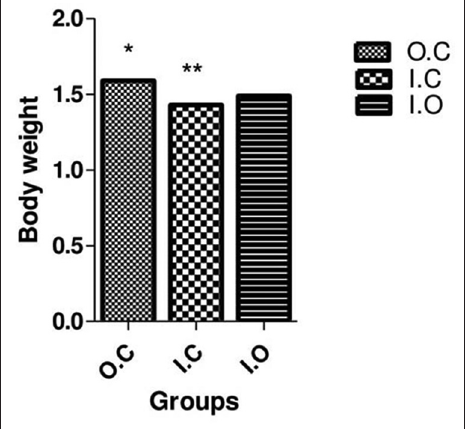
Figure-1: Group (G) body weight changes during 10 weeks. Data are expressed as mean±SD. In each row, the values with different stars indicate *significant difference among groups (p<0.05). OC=Outdoor control group, IC=Indoor cages, IO=Indoor open.